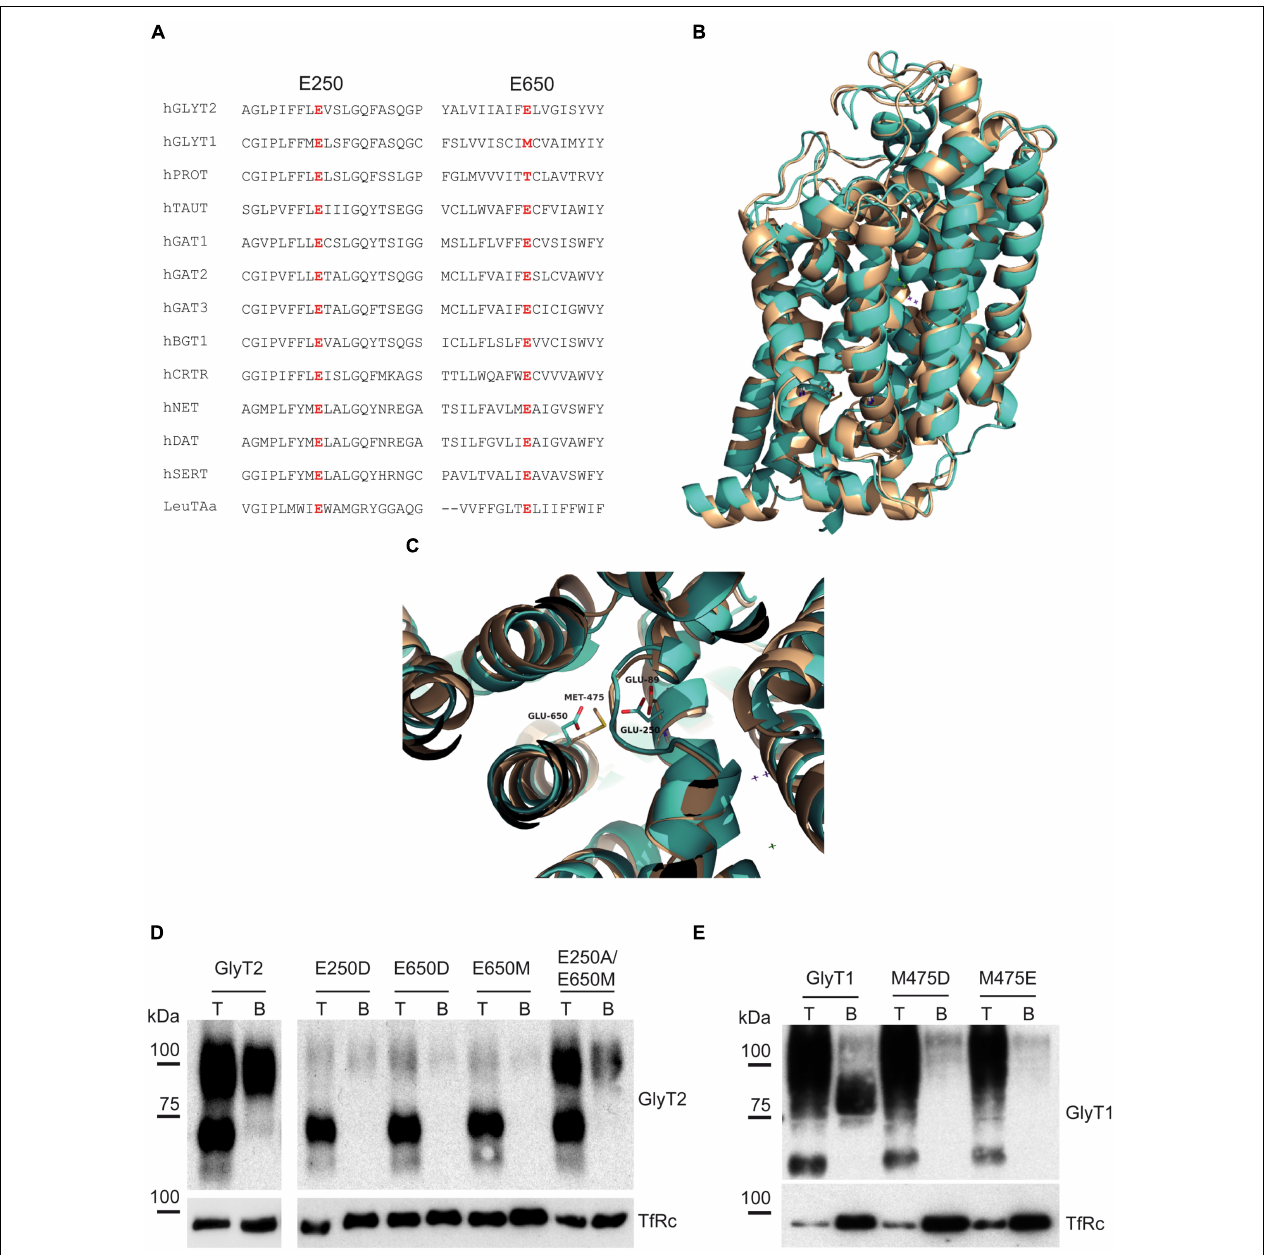
FIGURE 2 | GlyT1 and GlyT2 alignment and mutant expression. (A) Alignment of the amino acid sequences of TM2 and TM10 of rat NSS transporters using the ClustalW program. (B,C) Structural alignment of modeled GlyT1 and GlyT2 showing GlyT2 Glu250 and Glu650 and GlyT1 Glu89 and Met475 in stick representation. (D,E) Surface expression of GlyT2 (D) and GlyT1 (E) mutants assessed by surface biotinylation. T, total transporter; B, biotinylated transporter; TfRc, transferrin receptor as loading control.